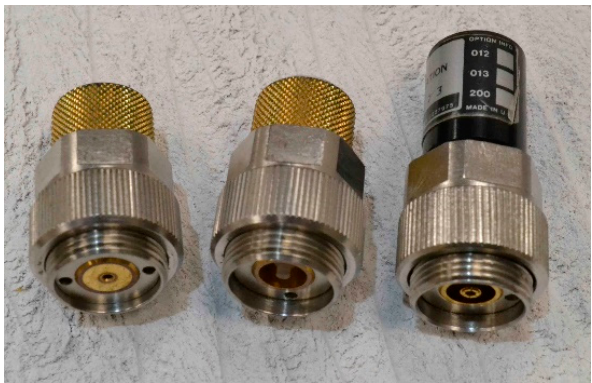
Figure 4. GPC-7 impedance standards (left to right: short-circuit, open-circuit and low-band load).